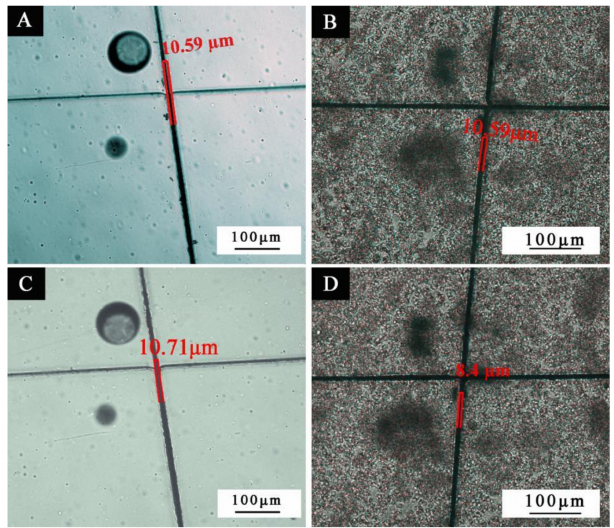
Figure 11. Optical images of coating films with and without microcapsules before and after self- repairing: without microcapsules ( A ) before self-repairing, ( C ) after self-repairing; with microcapsules ( B ) before self-repairing, ( D ) after